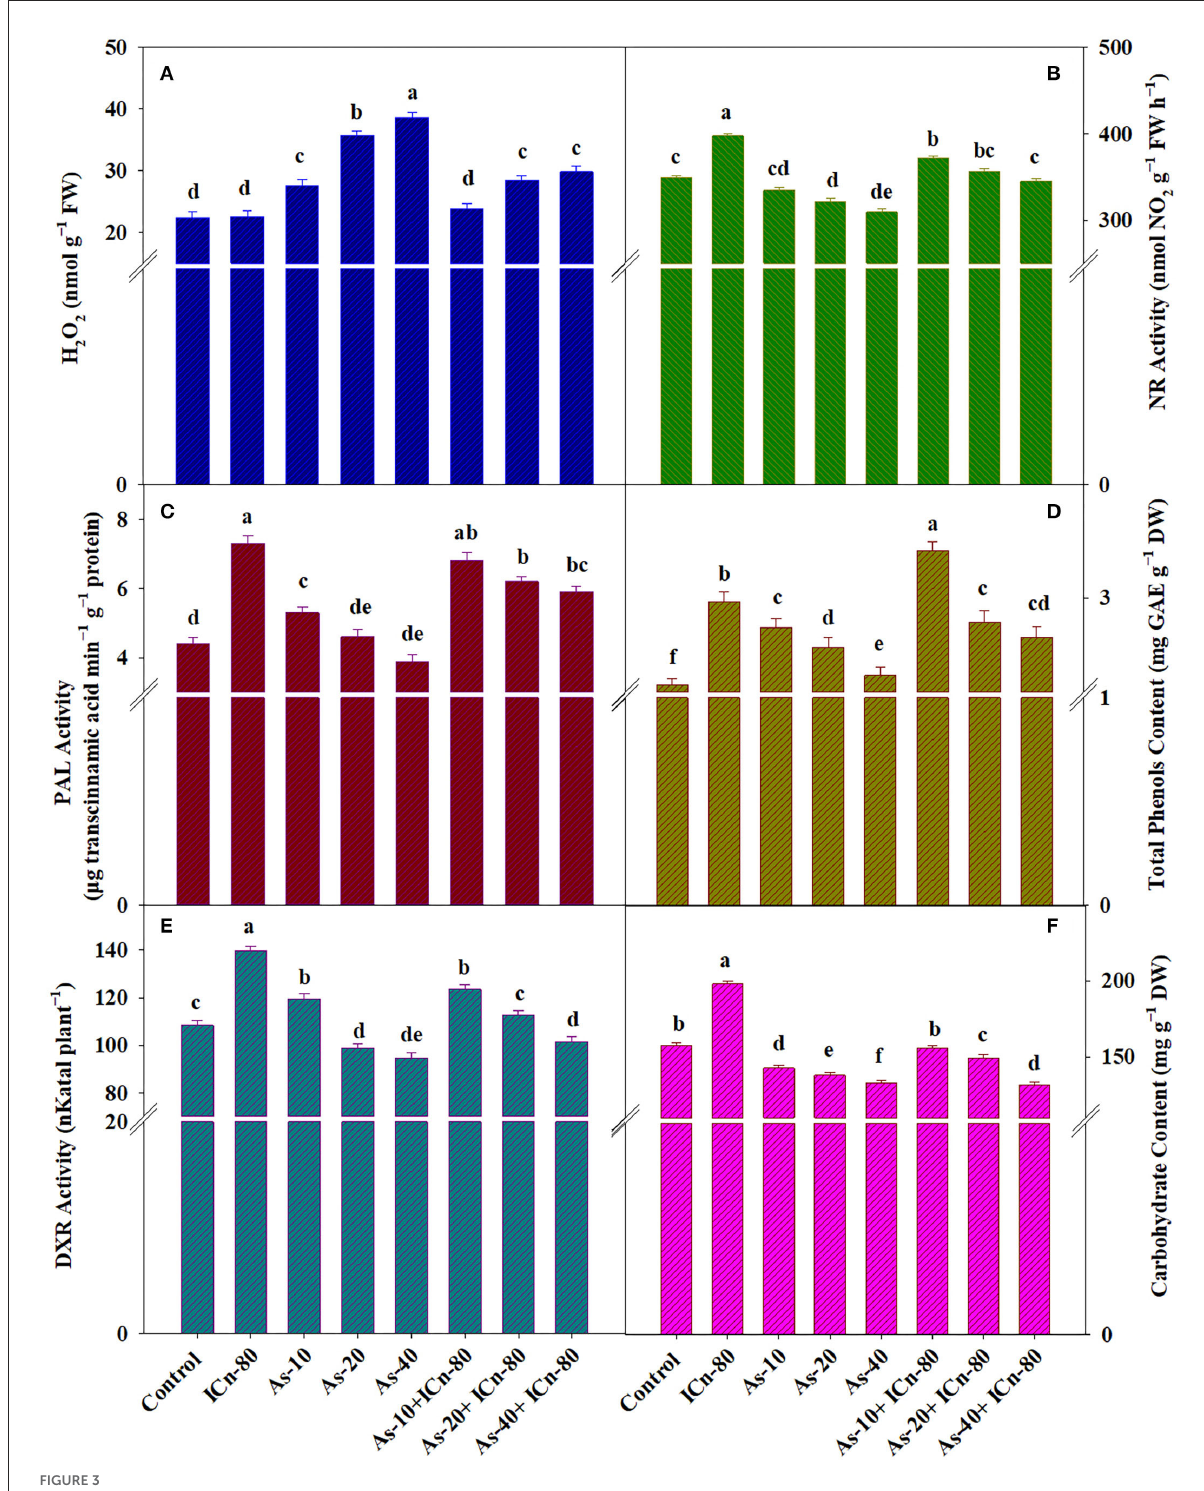
FIGURE3 H 2 O 2 content (A) , nitrate reductase activity (B) , phenylalanine ammonia lyase (PAL) activity (C) , total phenol content (D) , deoxy-D-xylulose-5-phosphate reductoisomerase (DXR) activity (E) , and carbohydrate content (F) of peppermint ( Mentha piperita L.) at 150 days after transplanting with/without As stress (10, 20, or 40mg kg − 1 of soil, as Na 2 HAsO 4 · 7H 2 O) and treated with ICn (80mg L − 1 ). Data are presented as treatment mean ± SE ( n = 5). Bars with the same letters are not significantly dissimilar ( P <